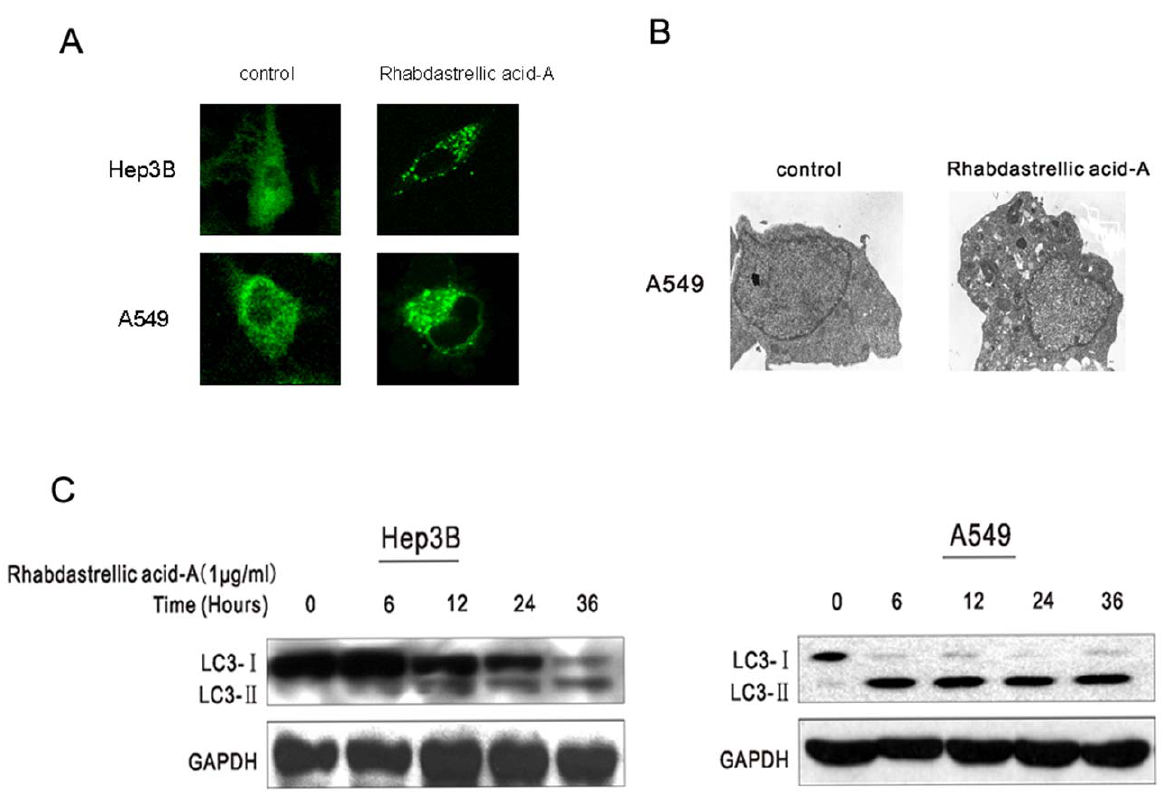
Figure 4. Rhabdastrellic acid-A induced autophagy in Hep3B and A549 cells. A. Hep3B and A549 cells were transfected with an expression construct for LC3 fused to yellow fluorescent protein (YFP-LC3) for 24 h. Thereafter, cells were treated with or without 1 m g/mL or 4 m g/mL Rhabdastrellic acid-A for 36 h, and visualized under a confocal microscope. B. Electron micrograph showing autophagic vacuole of A549 cells following 4 m g/mL Rhabdastrellic acid-A treatment. C. Rhabdastrellic acid-A time-dependently induced the formation of LC3-II, a marker for autophagy. Hep3B and A549 cells were treated with 1 m g/mL Rhabdastrellic acid-A for the indicated times. Lysates were analyzed by immunoblotting with LC3 antibody.